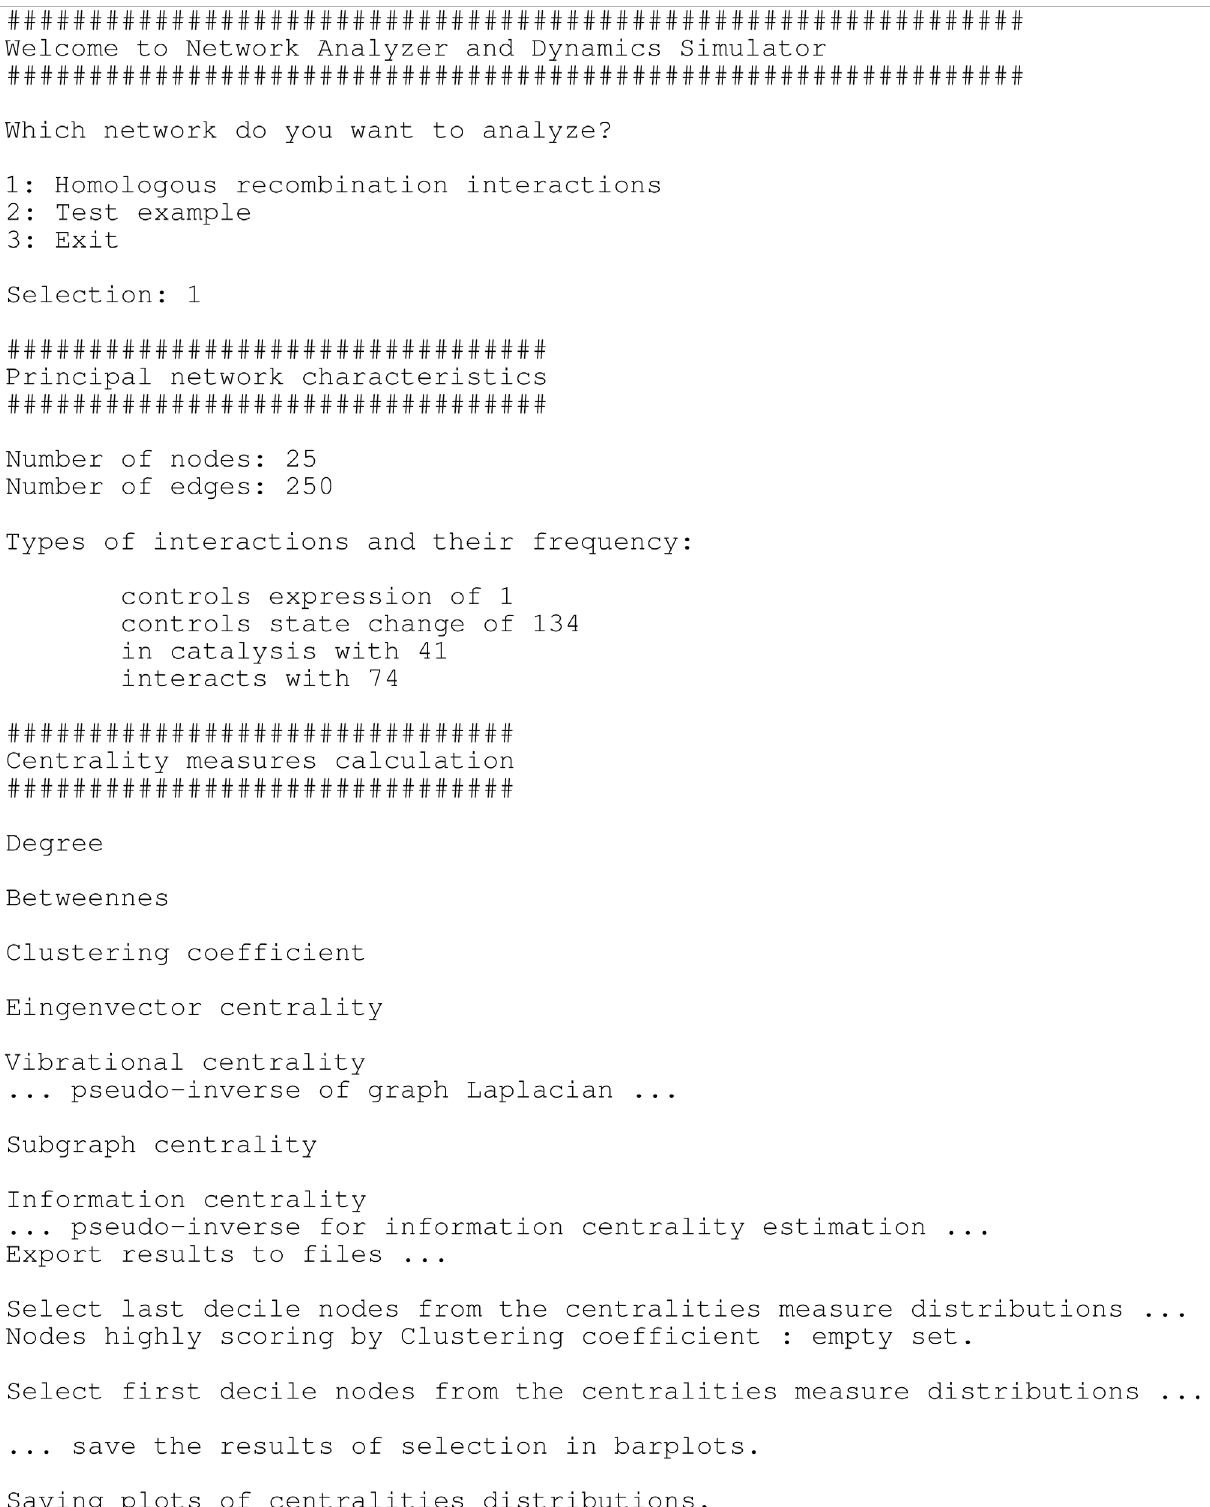
TABLE 1 | Interactive graphical user interface of NADS software showing the options and the task concerning the generation of ODE equations and their solution.